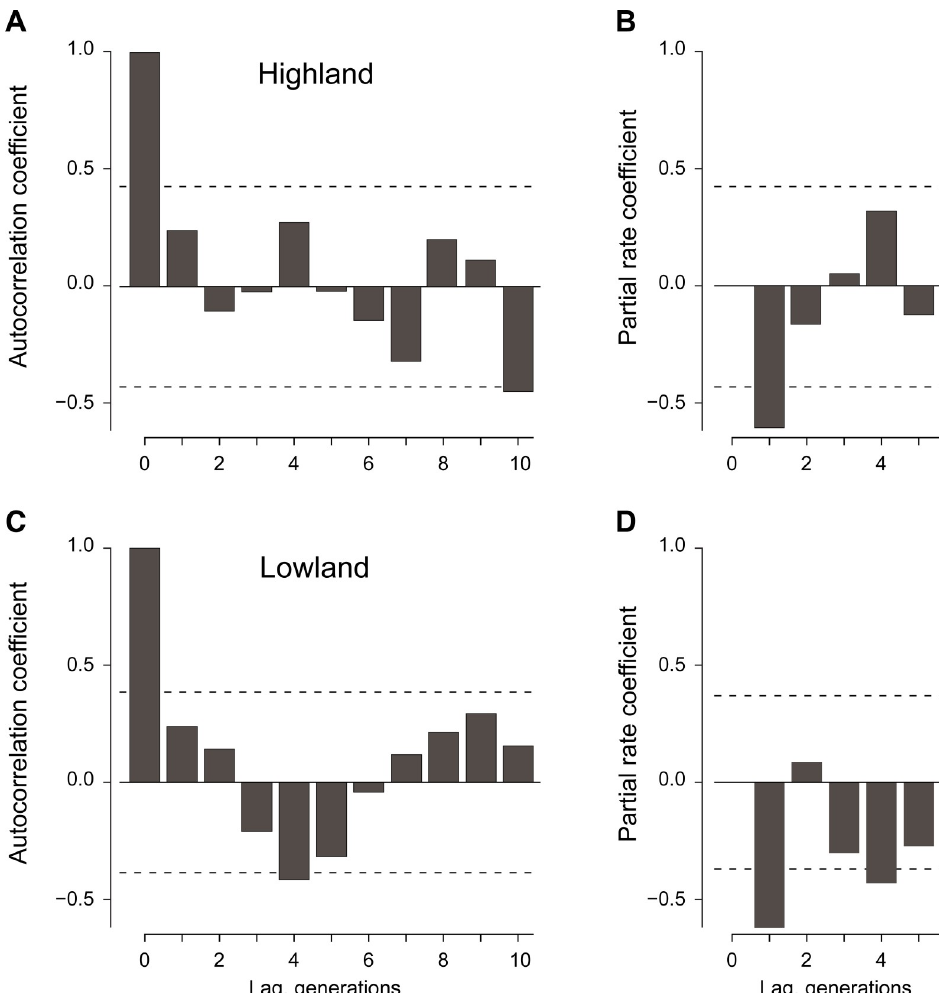
Fig 5. Temporal autocorrelation coefficients (A, C) and partial rate correlation coefficients (B, D) among consecutive generations of female P . downs i at the highland and lowland study sites. Coefficients outside the dashed horizontal bands in each panel are significantly different from zero ( α =